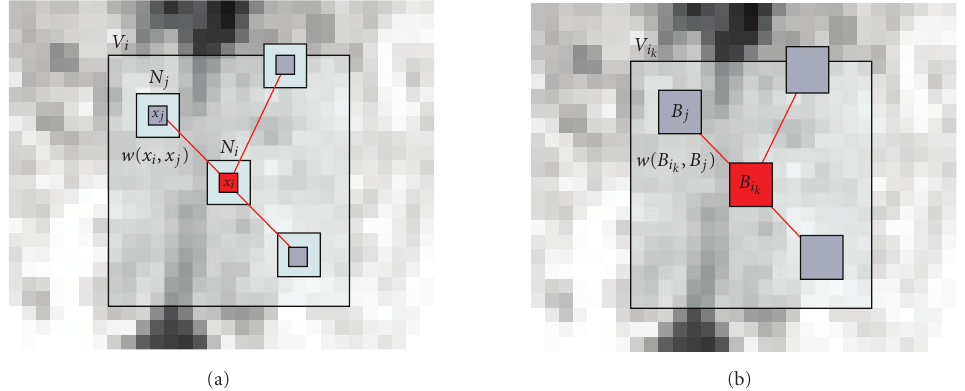
Figure 1: (a) Usual voxelwise NL-means filter: 2D illustration of the NL-means principle. The restored value of voxel x i (in red) is the weighted average of all intensities of voxels x j in the search volume V i , based on the similarity of their intensity neighborhoods u ( N i ) and u ( N j ). In this example, we set d = 1 and M = 8. (b) Blockwise NL-means filter: 2D illustration of the blockwise NL-means principle. The is the weighted average of all the blocks B j in the search volume V i . In this example, we set α = 1 and M = 8. restored value of the block B i k k